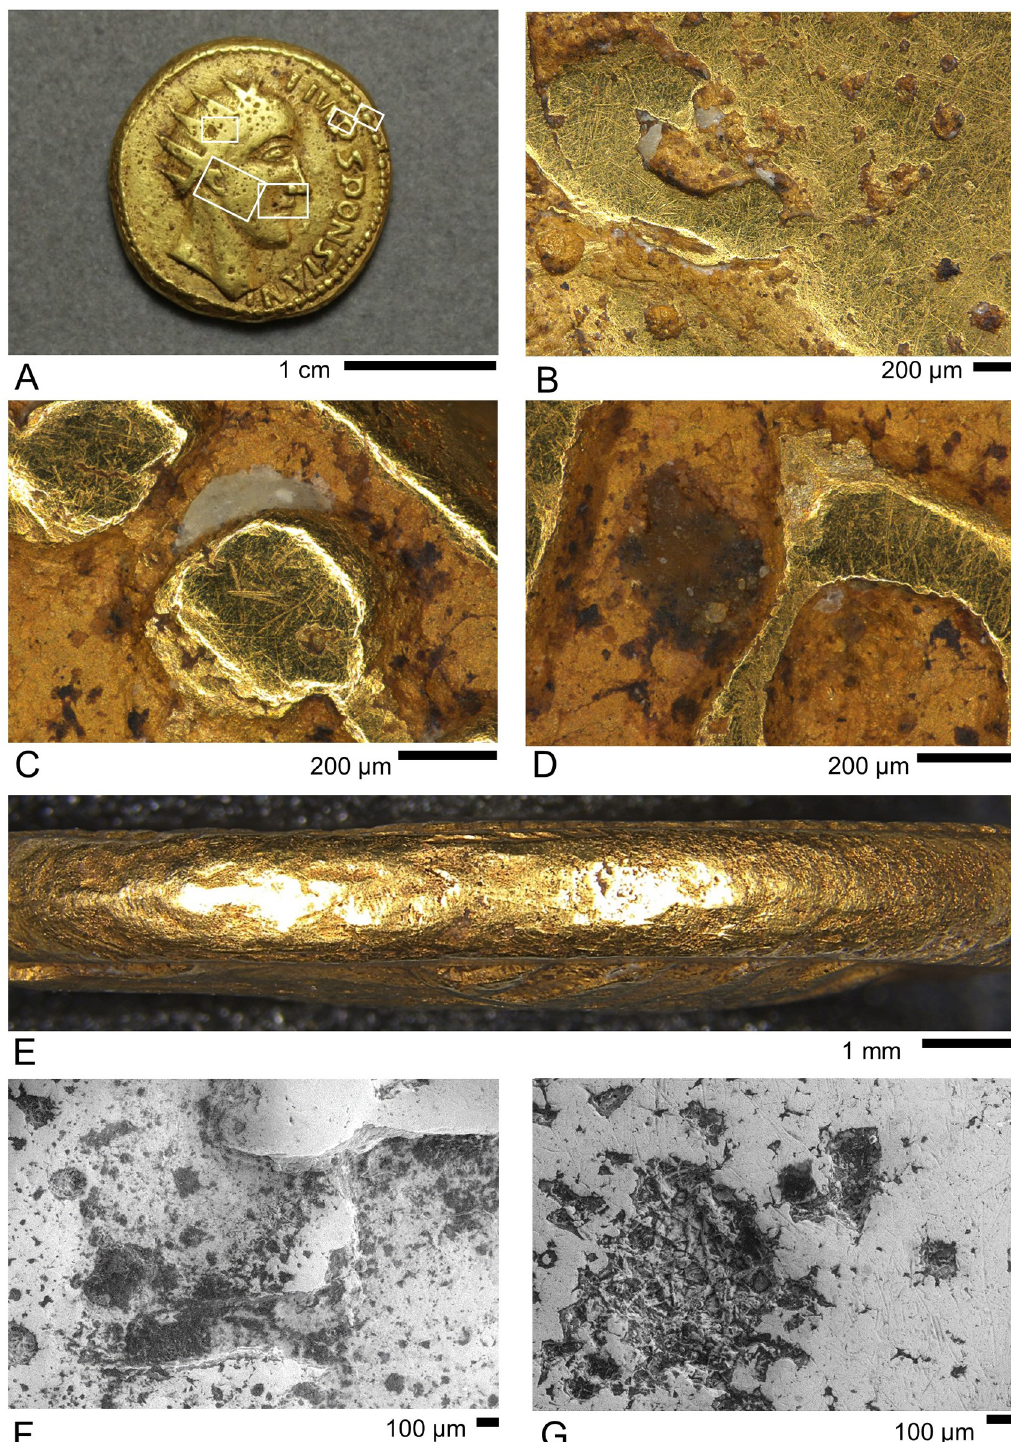
Fig 8. LM images of the obverse surface and edge of Sponsian coin GLAHM:40333. A) key to highlighted areas; B) detail of ear and cheek showing subcircular pits interpreted as casting air bubbles, within which the metal has an irregular surface where it did not impress the mould, wear scratches and areas of possible wax residue; C) detail of beading and edge showing wear scratches, possible wax residue and cementation spots; D) detail of lettering showing scratches, chipped edges, earthen deposit between letters and cementation spots; E) perpendicular view of edge; F) area of Sponsian’s mouth showing granular patches in recesses and remnant air bubbles; G) detail of large remnant air bubble. https://doi.org/10.1371/journal.pone.0274285.g008 PLOS ONE | https://doi.org/10.1371/journal.pone.0274285 November23,